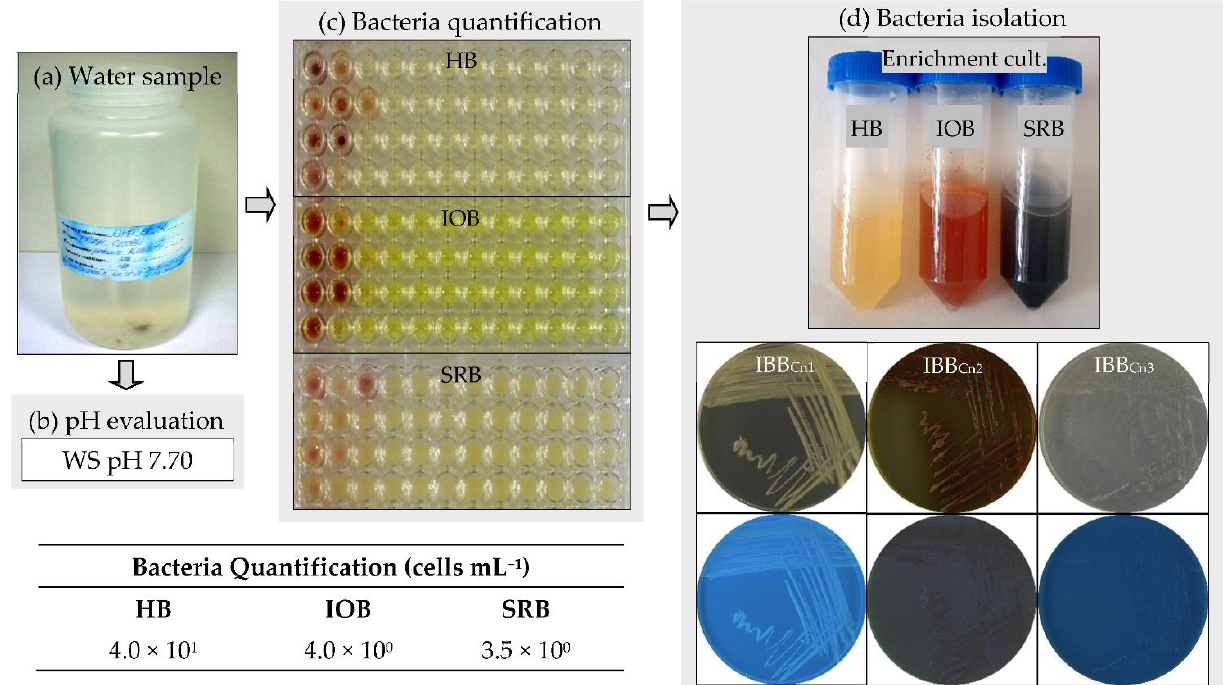
Figure 1. Bacteria quantification in the water sample and bacteria isolation. ( a ) Water sample. ( b ) pH evaluation of water sample (WS). ( c ) Bacteria quantification (MPN assay, cells mL − 1 ): hetero-